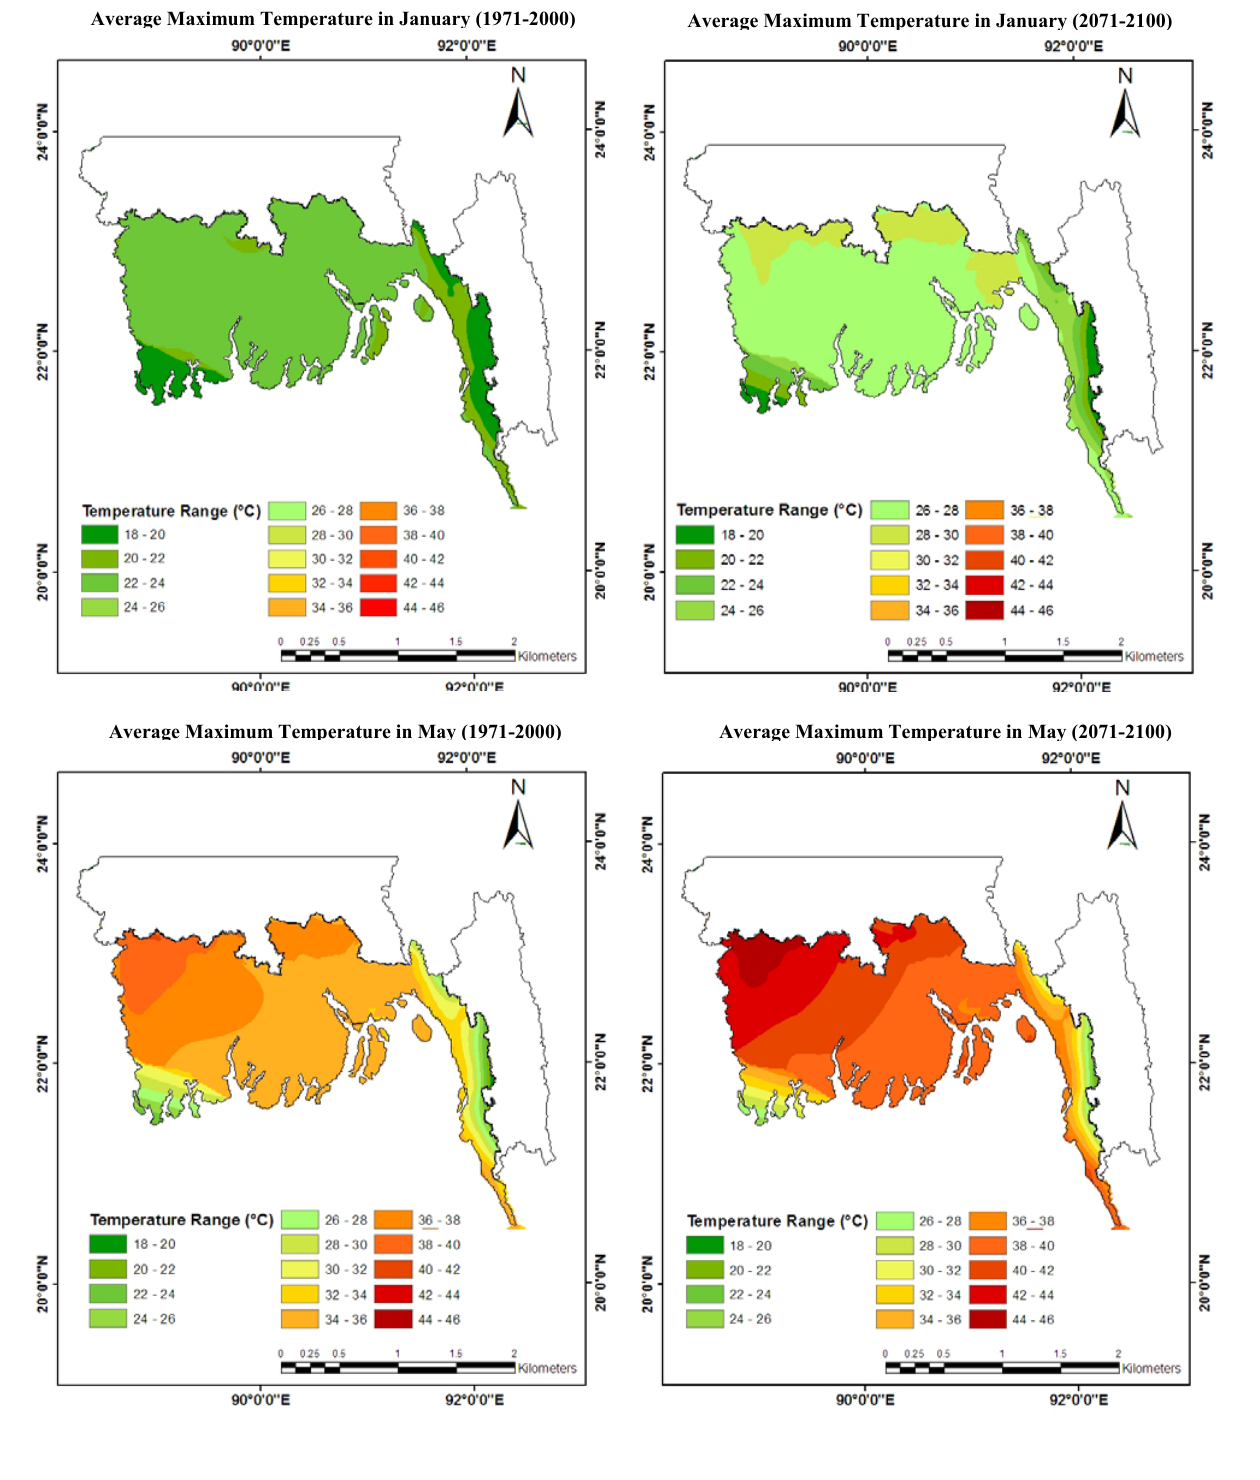
Figure 6. Spatial distribution of average maximum temperature in January and May (( top ) and ( bottom )): comparison between baseline (1971–2000) and simulated future